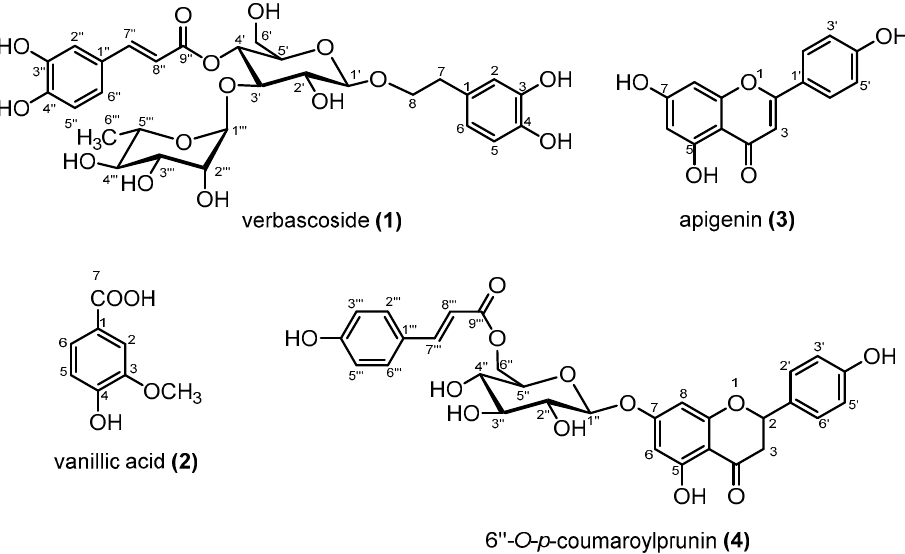
Figure 1. Chemical structures of compounds isolated from Blepharis linariifolia . Table 1. 1 H and 13 C-NMR spectroscopic data of verbascoside ( 1 ) in CD 3 OD.